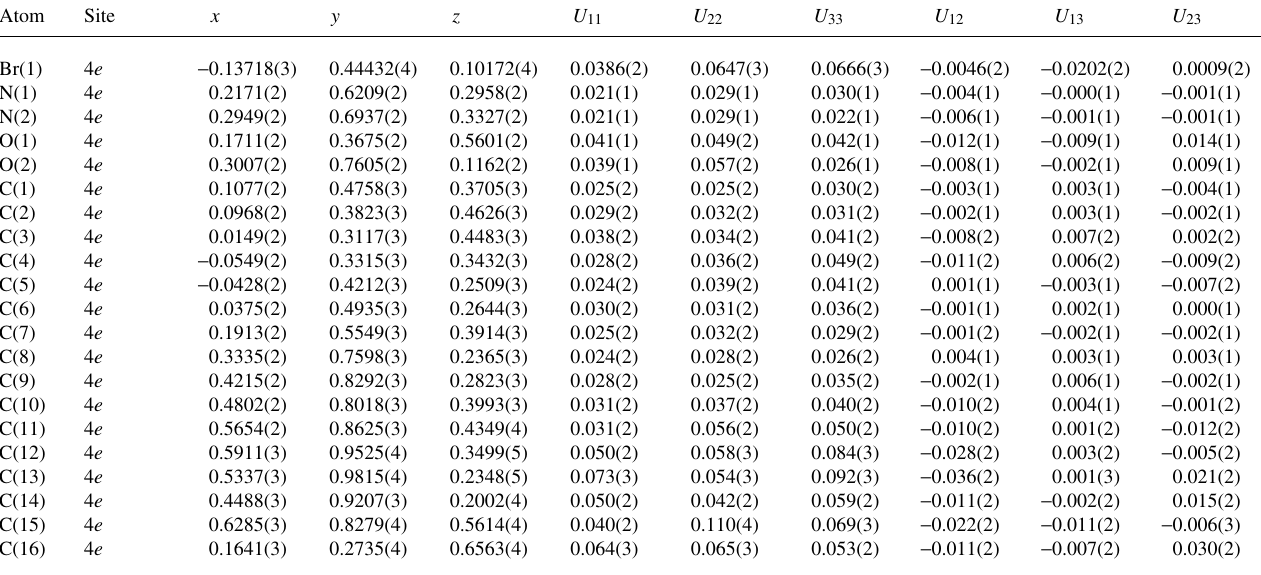
Table 3. Atomic coordinates and displacement parameters (in Å 2 )